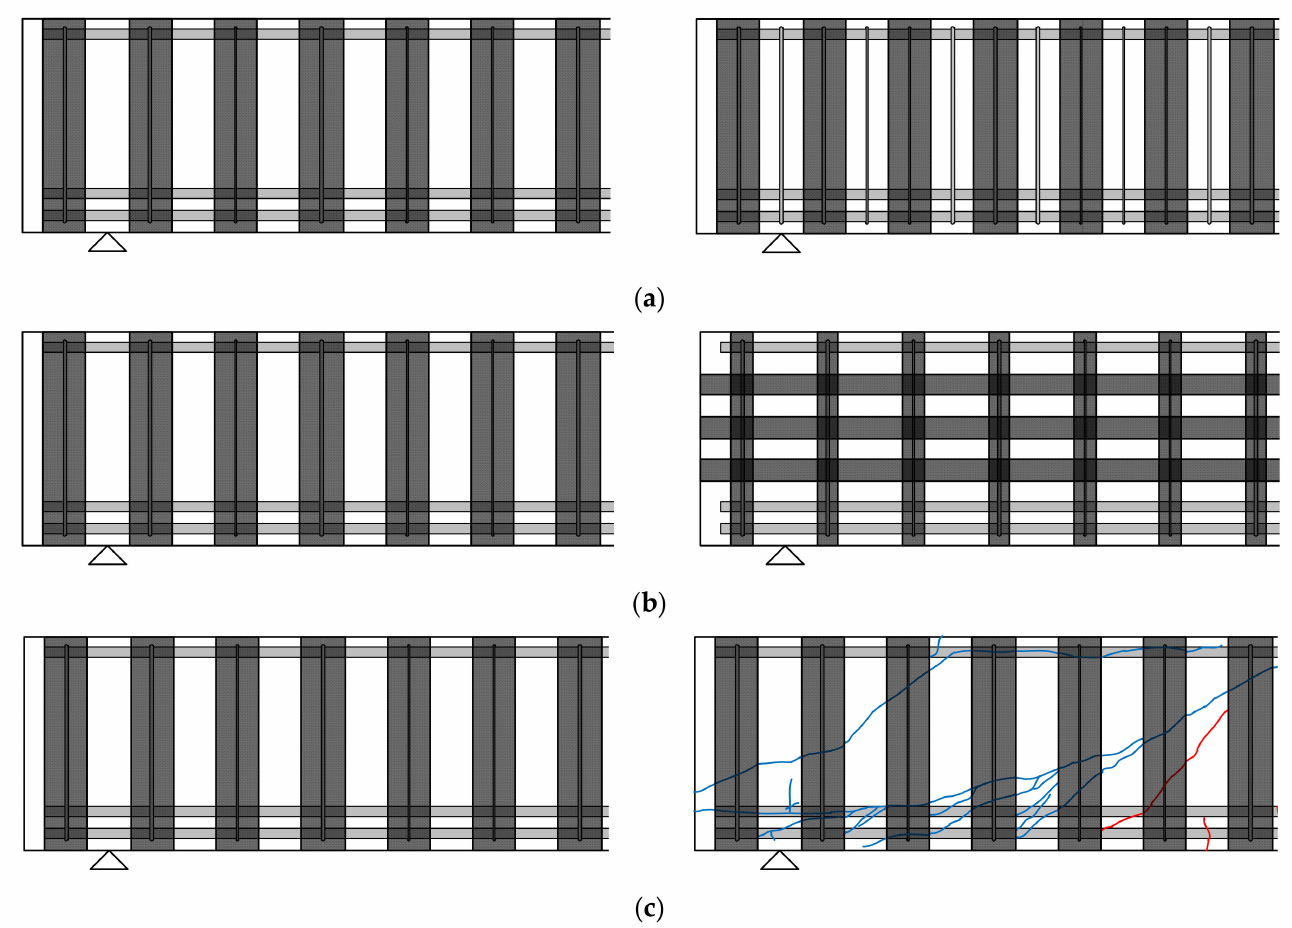
Figure 2. Main parameters of test specimens in the first series: ( a ) 200 mm vs. 100 mm stirrup spacing; ( b ) uni-directional vs. bi-directional CFRP layout; ( c ) uncracked vs.